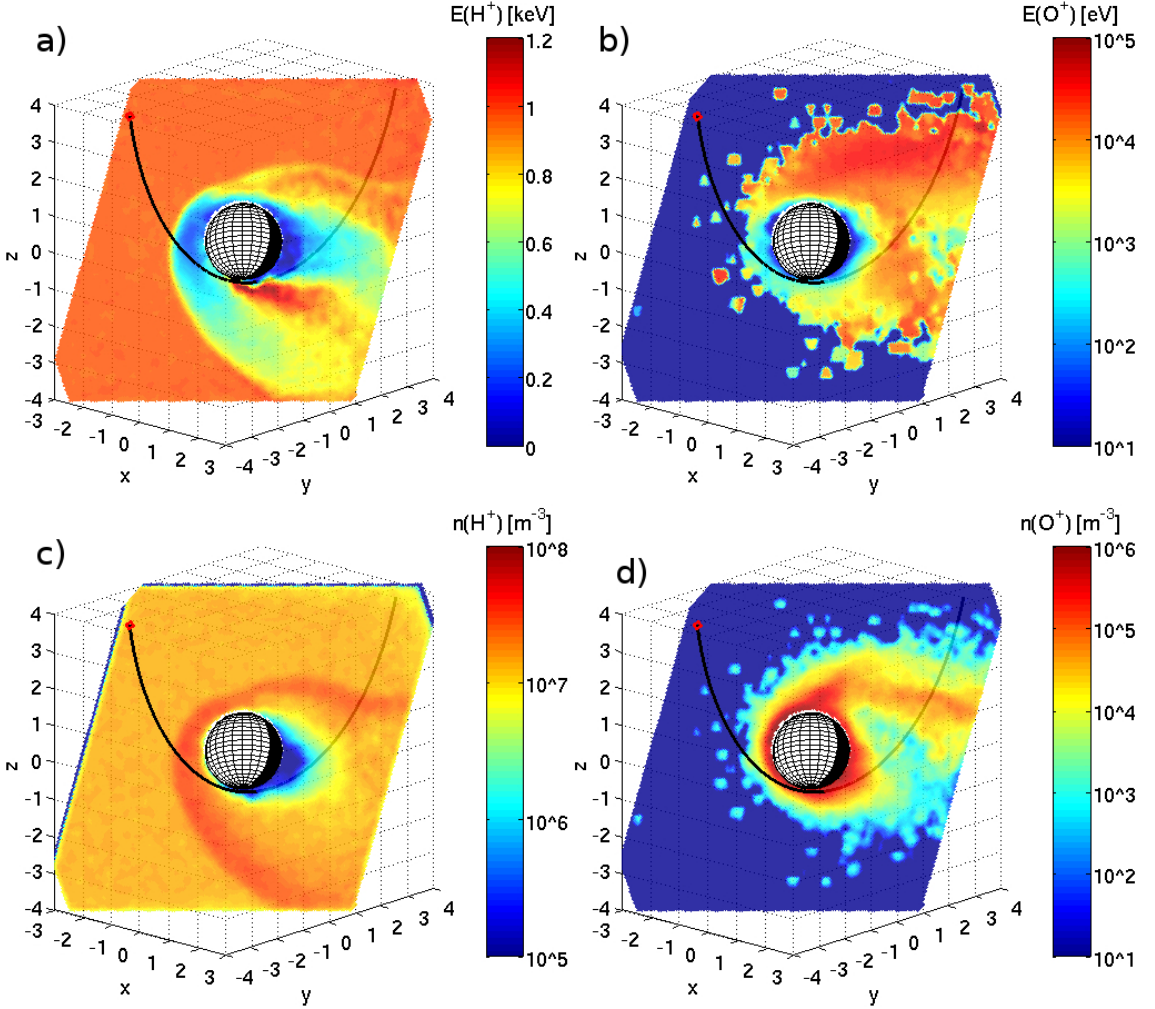
Fig. 4. Normal views to the spacecraft’s orbital plane for the bulk flow energy (upper panels) and density (lower panels) of the solar wind H + (left panels) and the planetary O + (right panels) in the nominal HYB-Venus simulation run. See the orientation of the orbital plane in Fig.